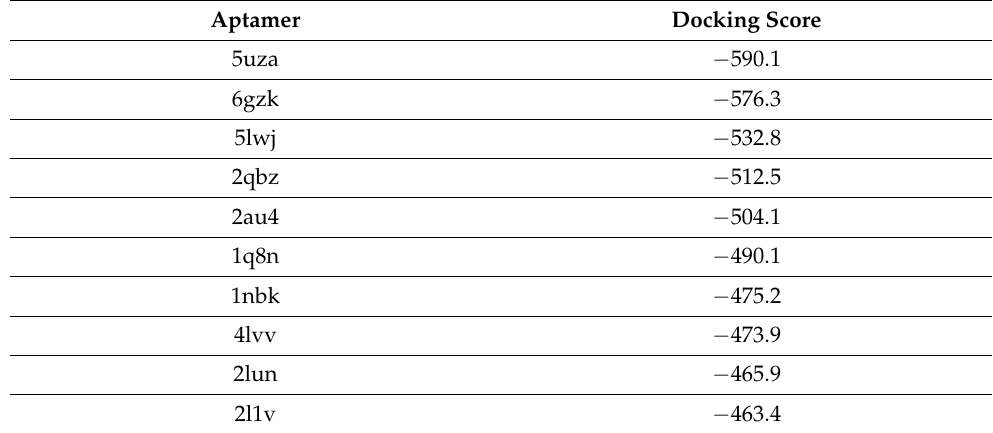
Table 2. Docking scores of the top ten binding aptamers to the target domain.